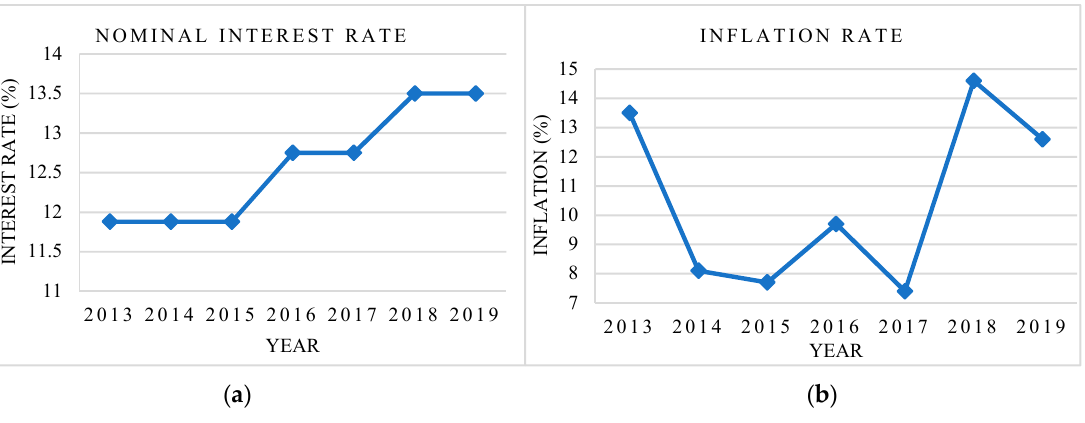
Figure 9. ( a ) Nominal interest rate, ( b ) Inflation rate.